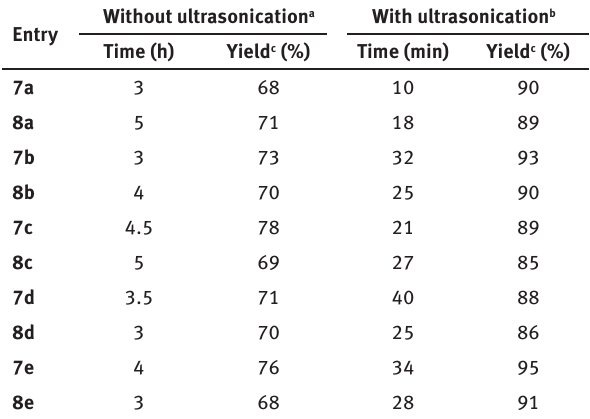
Table 1: Comparison of ultrasonication effect on the synthesis of AAPs ( 7a-e and 8a-e